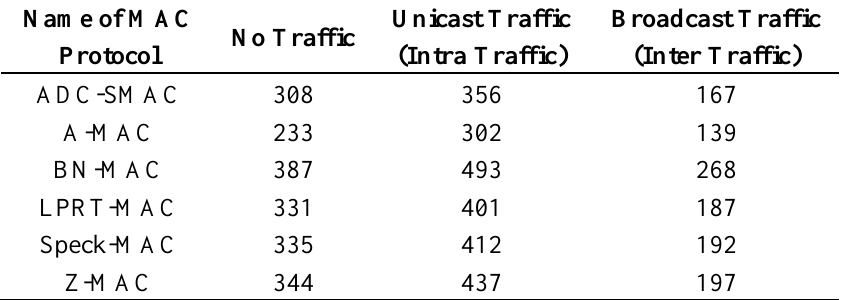
Table 3. Lifetime of hybrid MAC protocols over